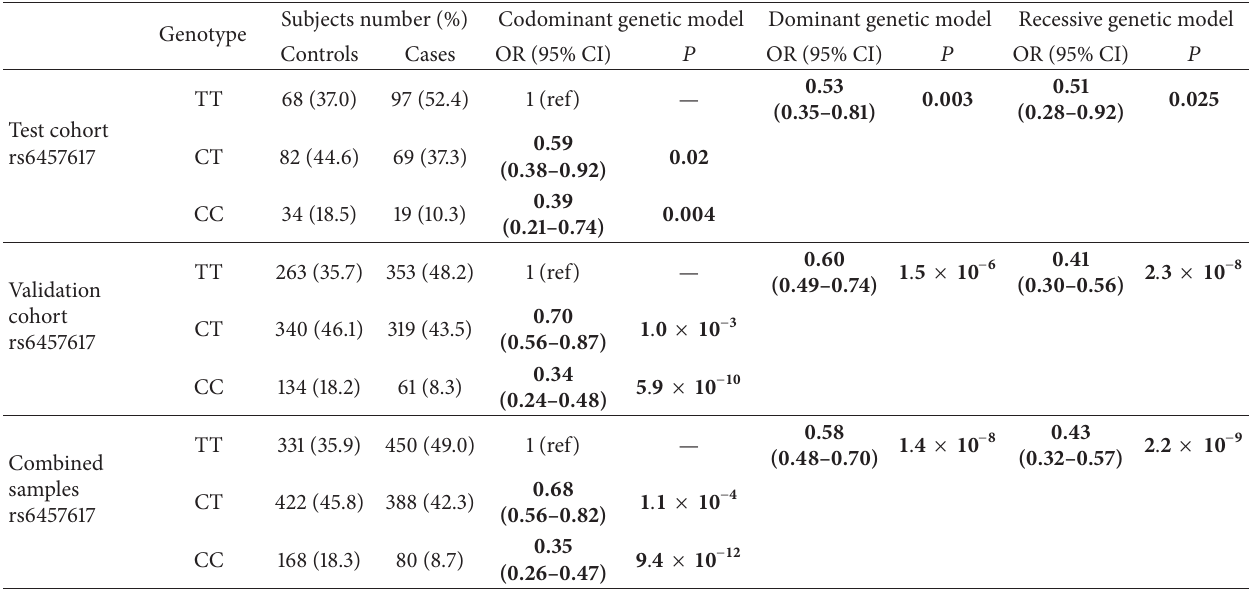
Table 4: Validation of SNPs in test cohort, validation cohort, and combined analyses (combined validation cohort with test